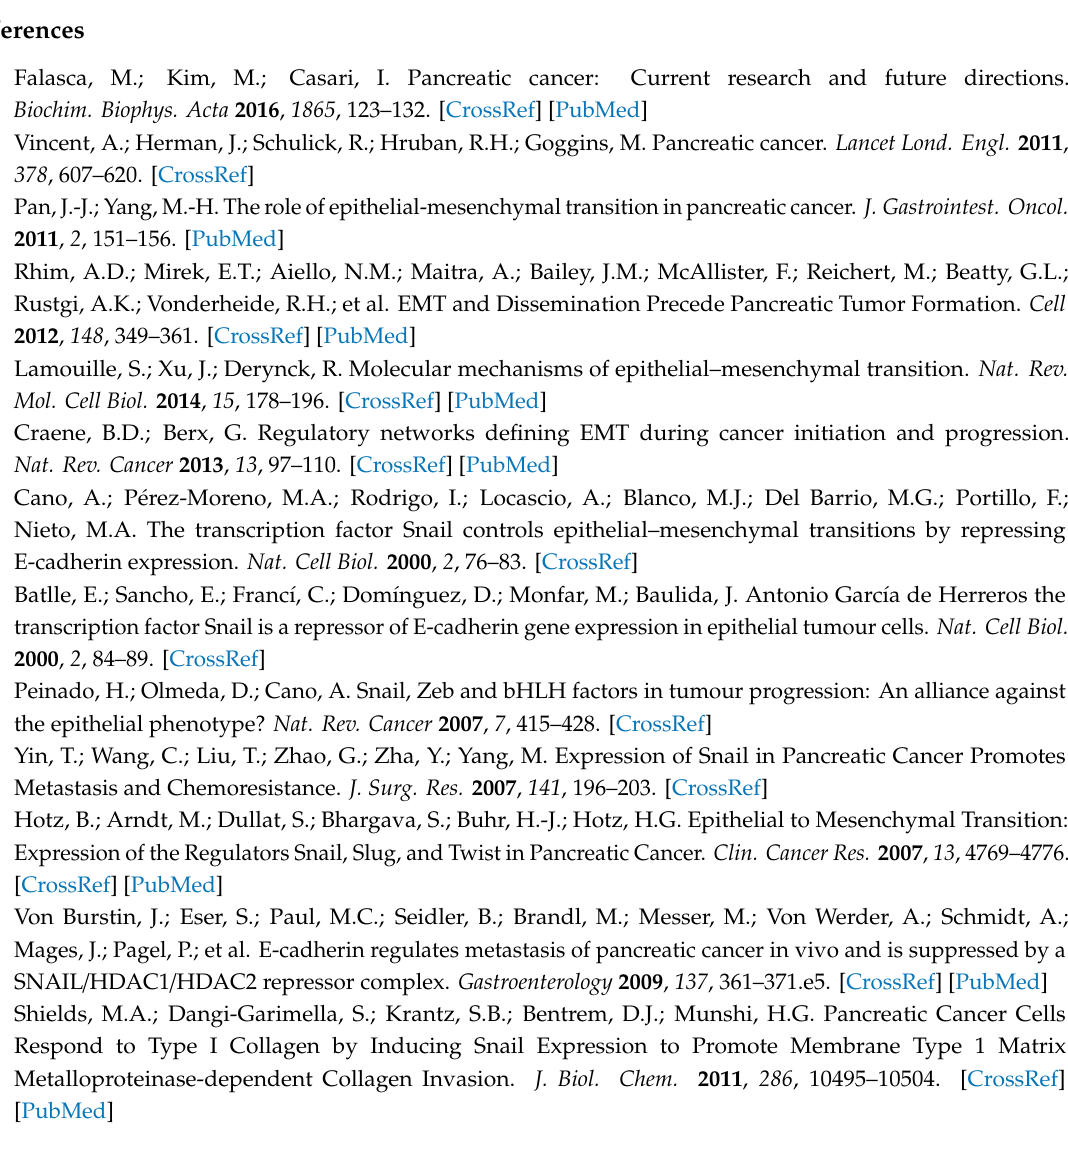
Table S1: 13 C metabolic flux analysis